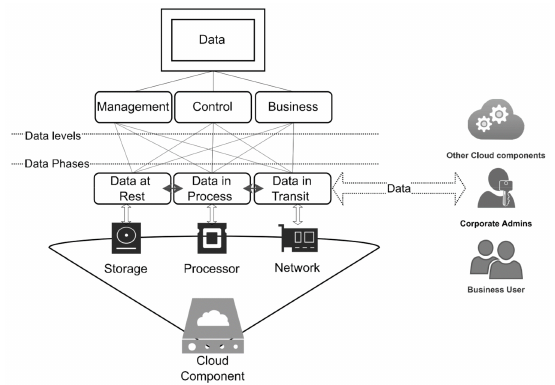
Figure 1. Data levels and